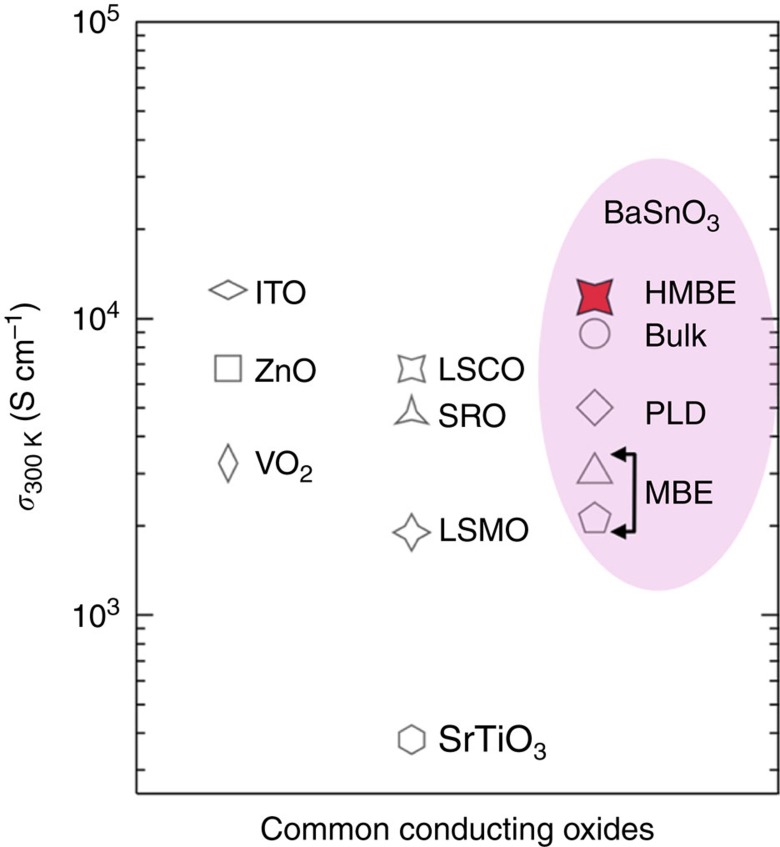
Comparison of conductivity values for common conducting oxides.Compilation of highest room temperature conductivity σ300 K of BaSnO3 bulk single crystal and films grown by various deposition techniques (taken from refs 9, 16, 22) including hybrid molecular beam epitaxy. The highest known σ300 K for common transparent conducting oxides (ITO=indium tin oxide, ZnO) and other metallic oxides as conductive electrodes for high frequency applications (VO2, LSCO=La0.5Sr0.5CoO3, SrTiO3, LSMO=La0.7Sr0.3MnO3, SRO=SrRuO3) are shown for comparison (refs 49, 50, 51, 52, 53, 54, 55).